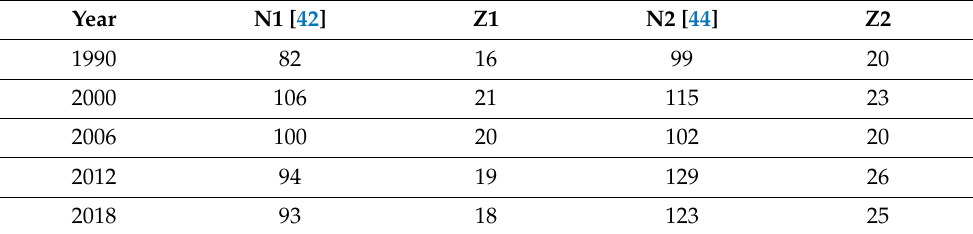
Table 2. The number of rain days (N1, N2) per year and the values assigned to the Z coefficient (Z = 0.2 ×